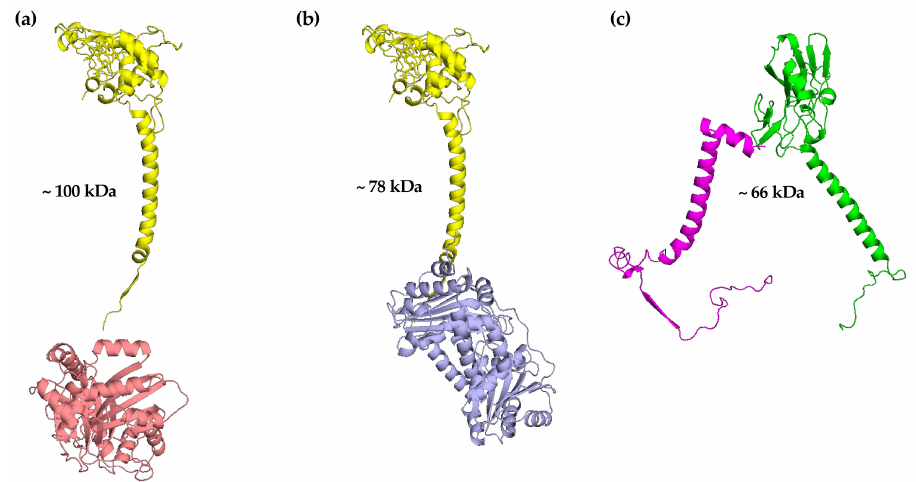
Figure 5. Additional bc 1 sub-complexes. ( a ) Sub-complex containing cytochrome c 1 (yellow) and core protein 2 (salmon). ( b ) Sub-complex containing cytochrome c 1 and core protein 1 (light blue). ( c ) Sub- complex containing ISP (green) and Qcr9p (magenta). This figure shows the interaction between the indicated bc 1 subunits on the basis of the crystal structure analysis carried out in yeast